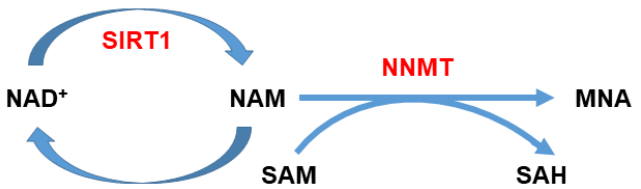
Figure 1. Nicotinamide (NAM) metabolism. NAM can be methylated by nicotinamide N -methyl- transferase (NNMT) utilizing S -adenosyl- L -methionine (SAM) as a methyl donor, which in turn is converted to S -adenosyl- L -homocysteine (SAH). NNMT activity can affect NAD + biosynthesis and